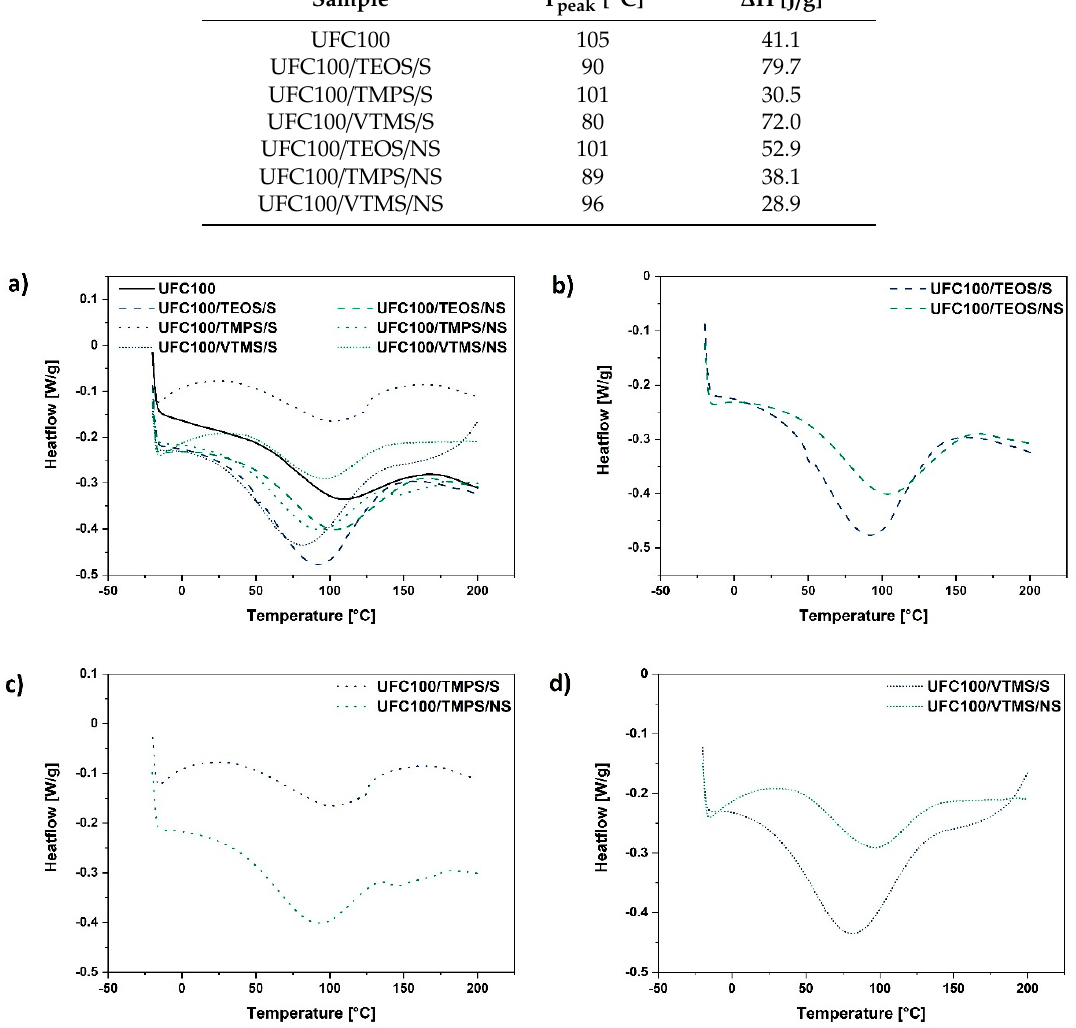
Table 3. Tabularized water evaporation peak temperatures (T peak ) and the assigned enthalpy values ( ∆ H) to this phenomenon for all analysed specimens.